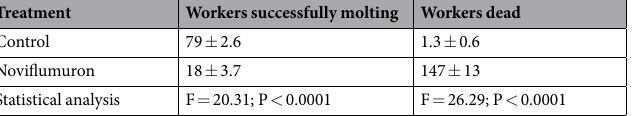
Table 1. Mean ( ± SE) number of workers molting and workers dead in control and noviflumuron treated colonies during the study period.